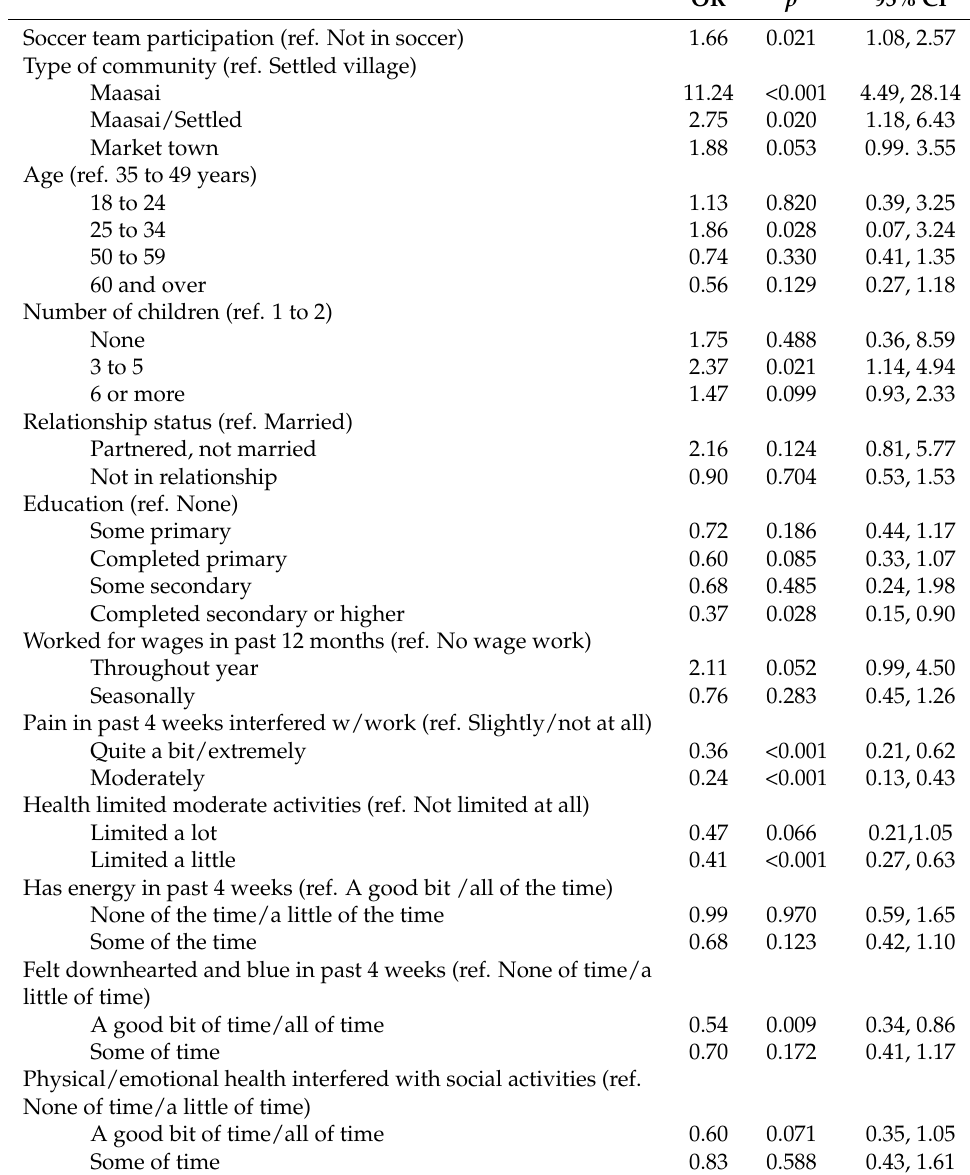
Table 2. Factors associated with self-reported good or excellent health ( n =